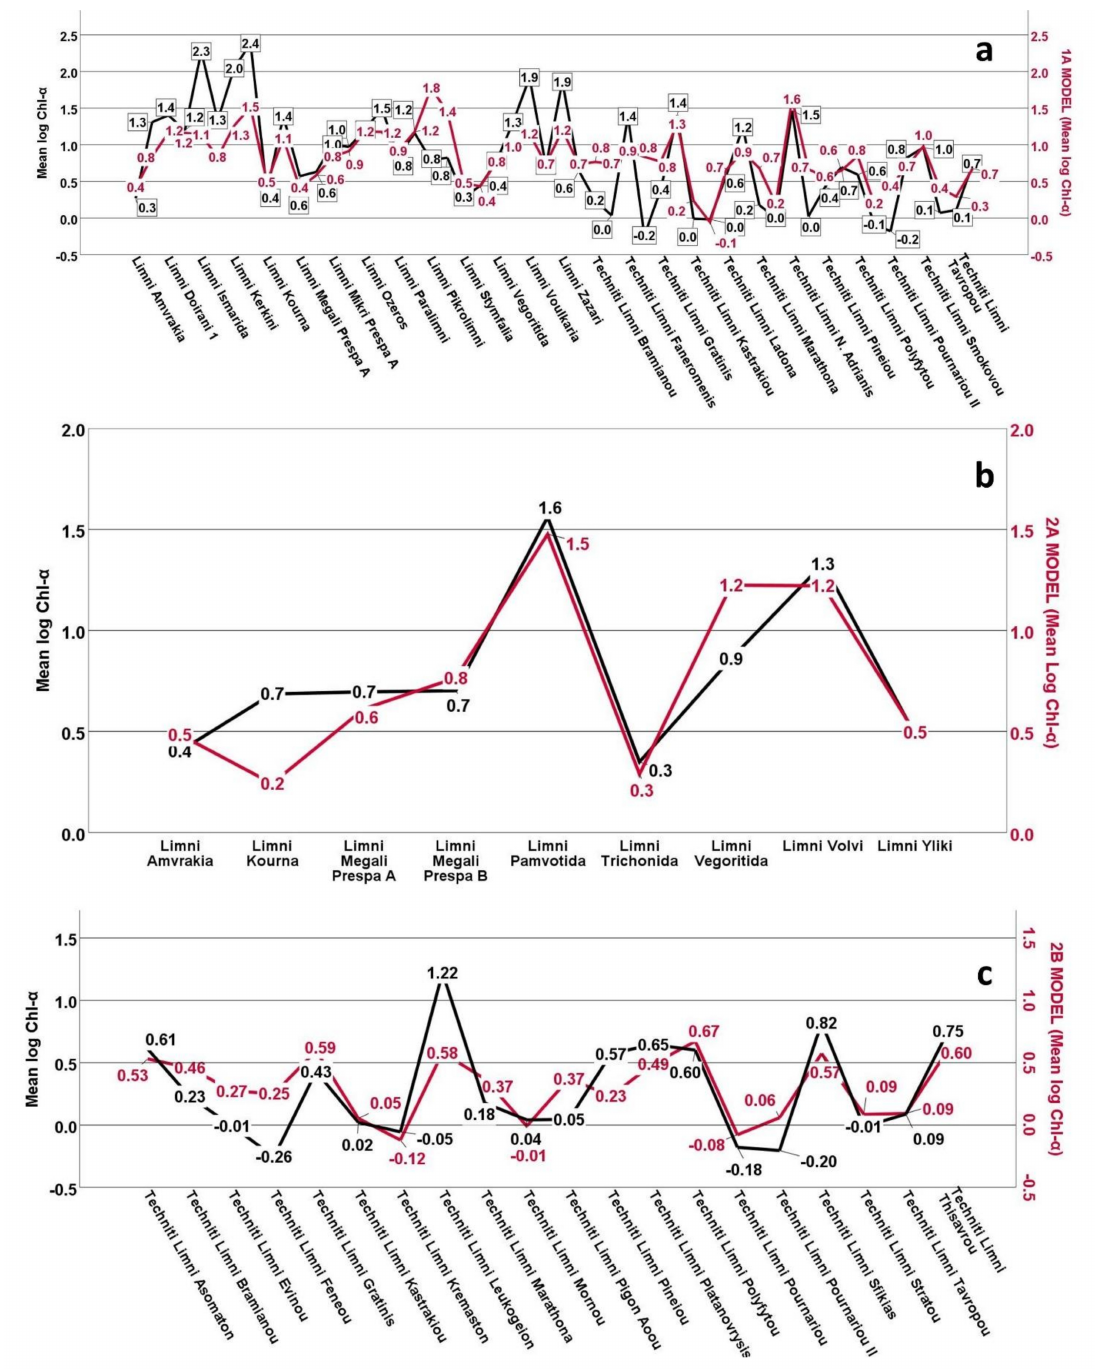
Figure 4. Spatial distribution per lake of mean in situ log Chl- a concentrations and mean satellite-derived log Chl- a concentrations based on the application of the ( a ) 1A model, ( b ) 2A model, and ( c ) 2B model, on both validation datasets (20% of the initial dataset, 2018